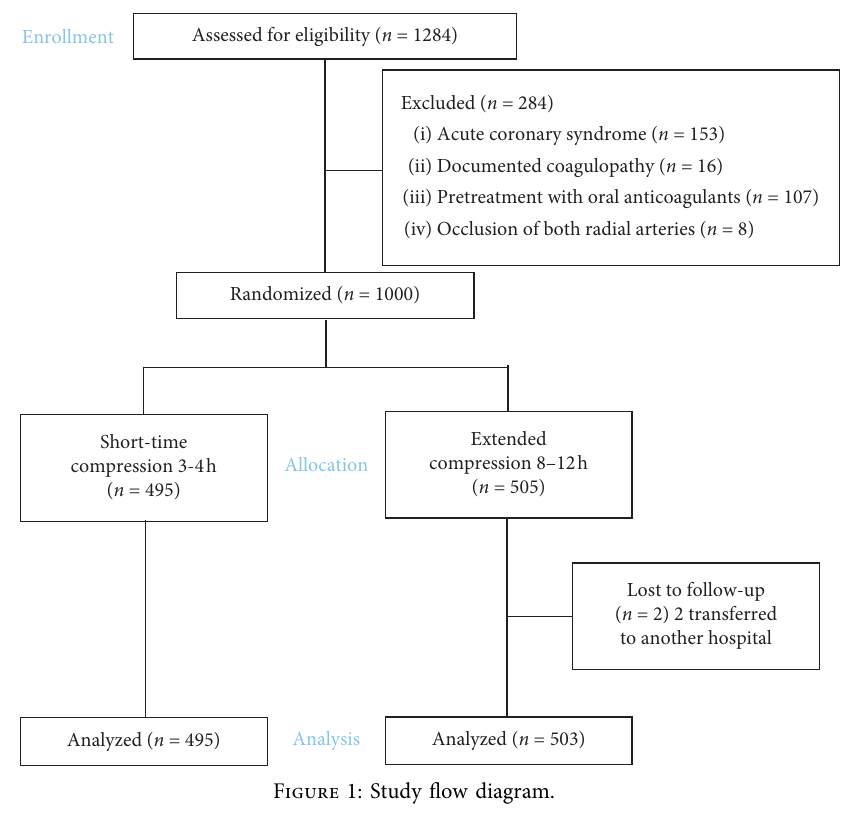
Figure 1: Study flow diagram.